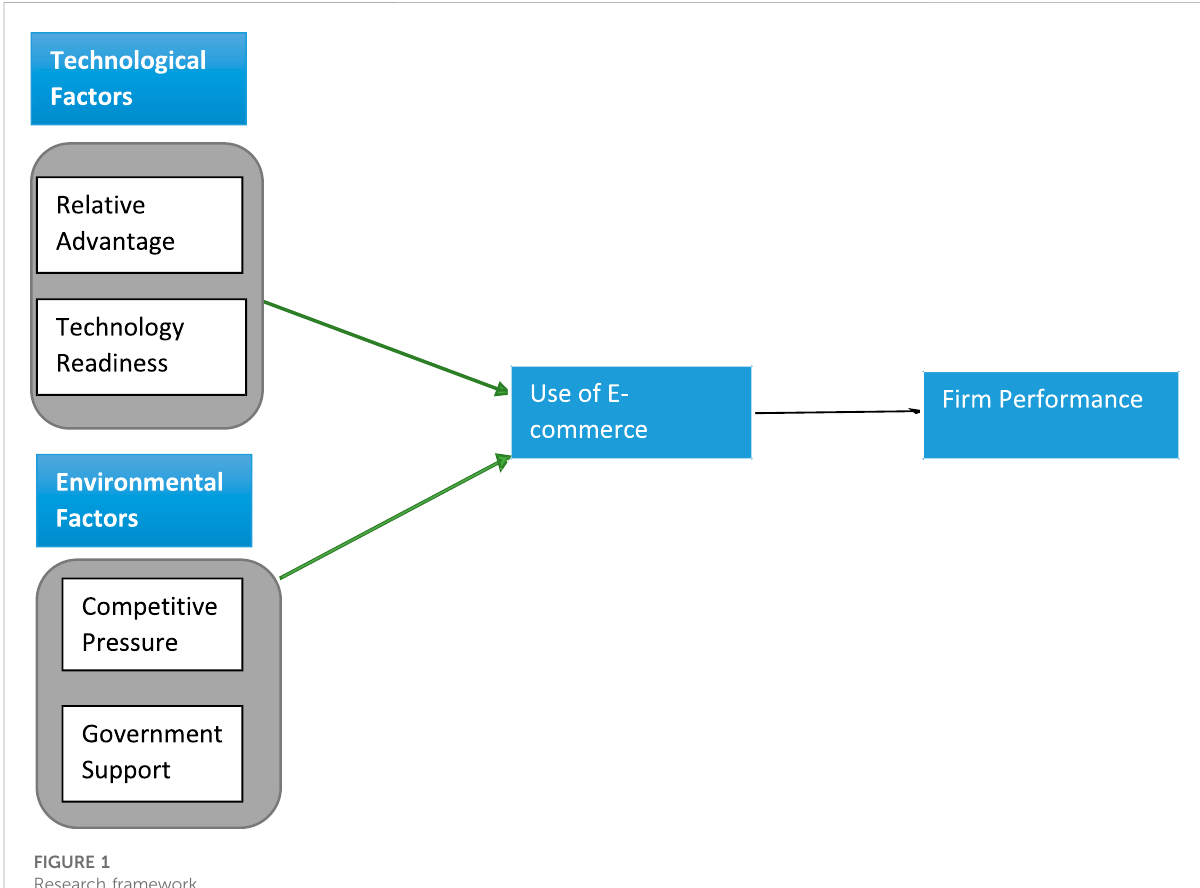
FIGURE 1 Research